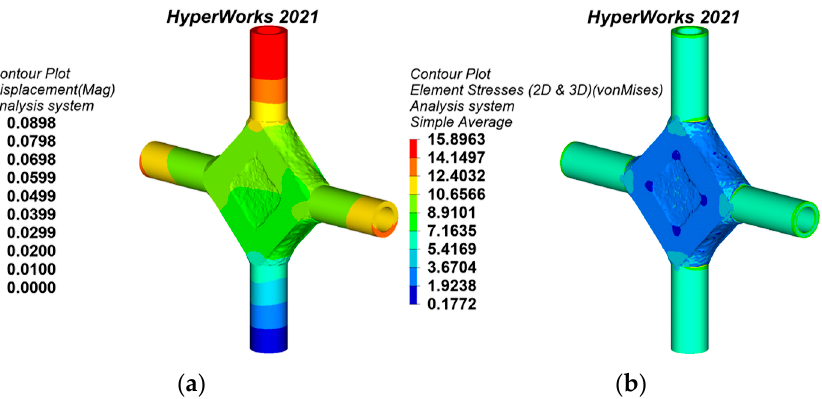
Figure 12. Static analysis results of the traditional topology-optimized joint: ( a ) displacement nephogram, ( b ) equivalent stress nephogram.